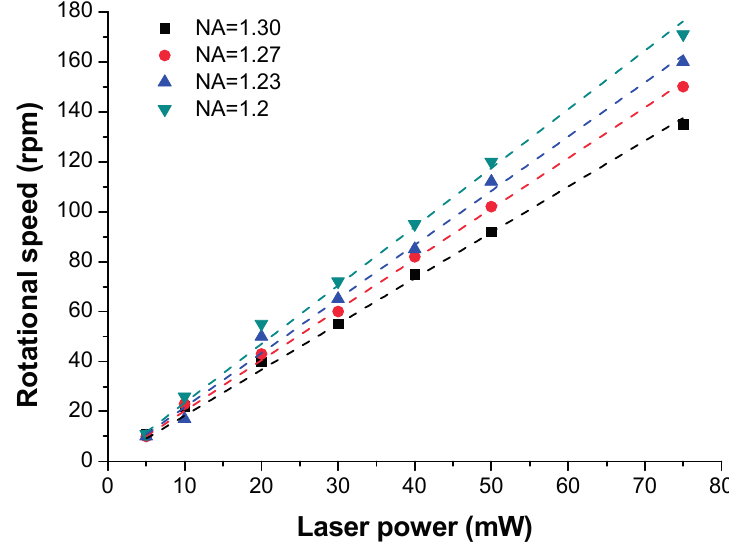
Figure 13. The evolution of rotational speeds under increasing laser power for micro-crews